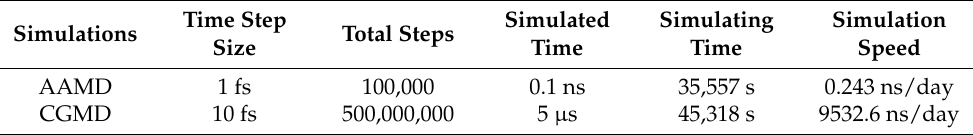
Table 2. Validation simulation comparisons using 24 CPU